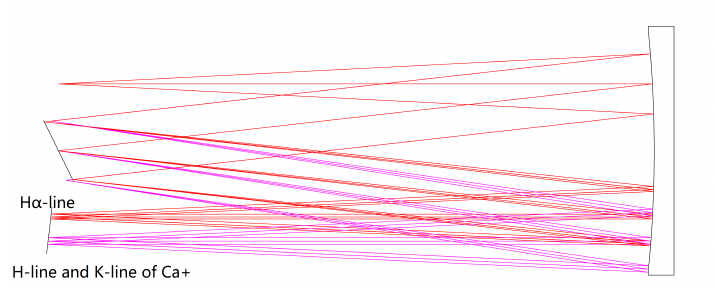
Figure 4. Dual-gratings spectrometer with H α line, H-line, and K-line of ionized